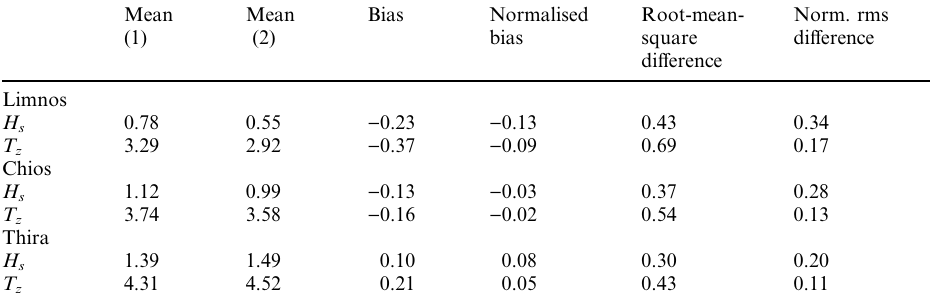
Table 3. Statistics for the storm February 1990, -80 points. Comparison of results from WAM model using UKMO